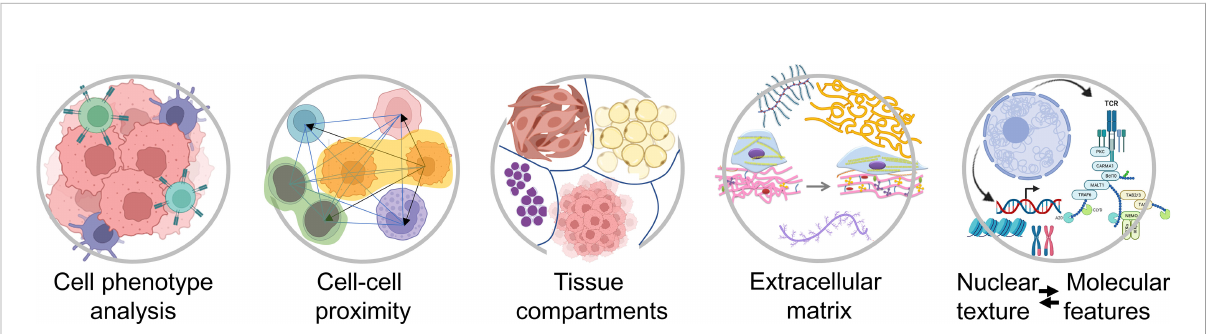
FIGURE 2 Examples of spatial characteristics within the tumor microenvironment that can be quanti fi ed using different types of computational image software. Created with BioRender.com.